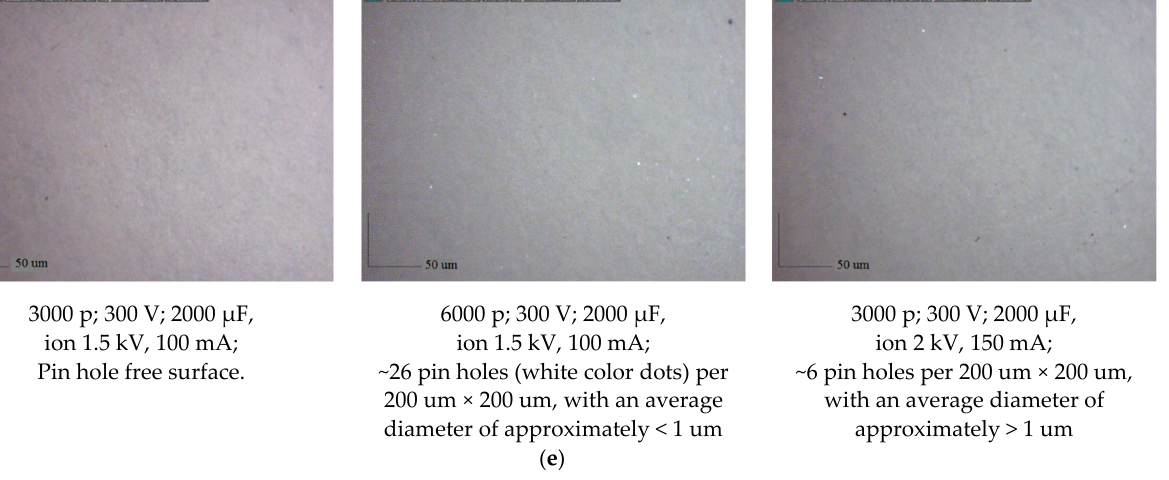
Figure 1. Bulk micromachined silicon membranes: ( a ) small non-patterned membrane with a side size of the square of 65 µm; ( b ) larger non-patterned membrane with a side size of the square of 1000 µm; ( c ) small meander-patterned membrane with a side size of the square of 65 µm; ( d ) technology flow of fabrication of the two parts of the sensing structure and a schematic view of the assembled device; ( e ) optical micrographs of the sensing coatings produced at different deposition conditions.